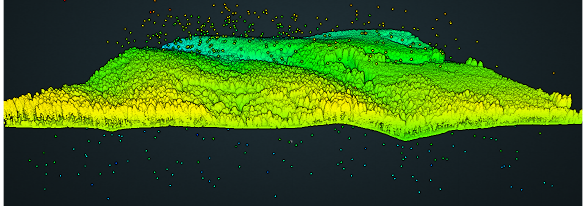
Figure 12 . Noise points affecting a LiDAR point block